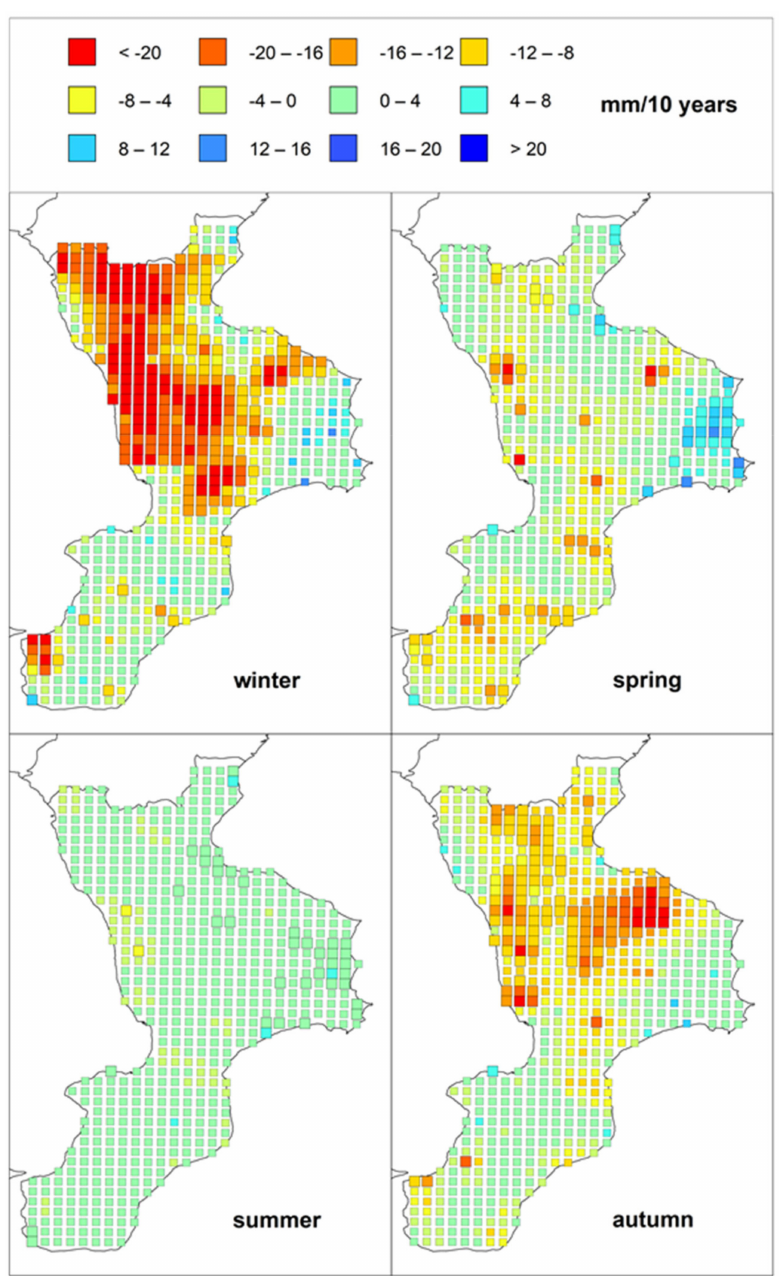
Figure 3. Seasonal trend maps. Squares dimension indicates the significance level of the trend: large squares p < 0.05, small squares